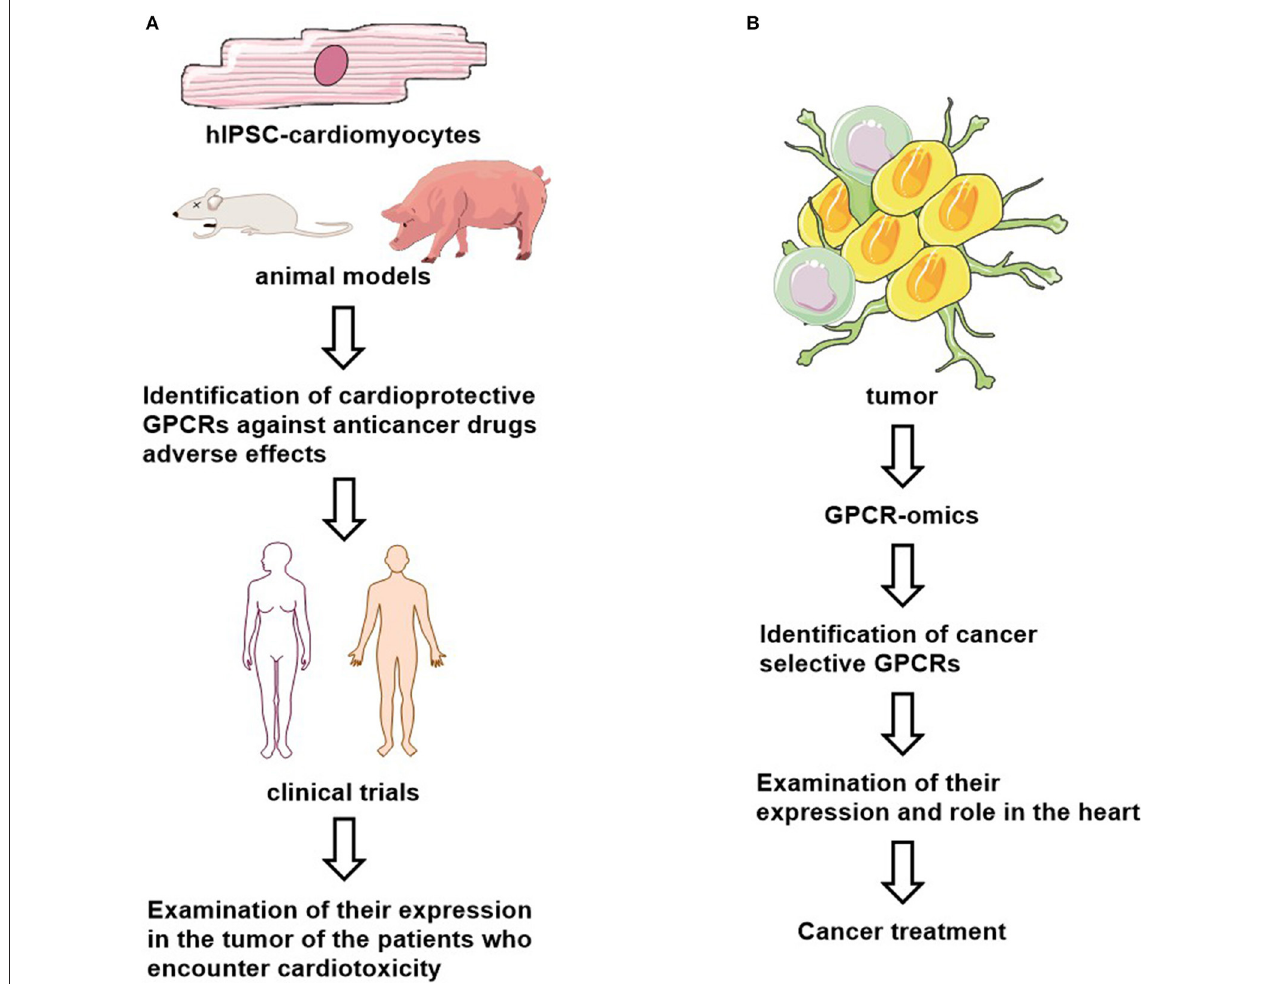
FIGURE 2 | Proposed cardioprotective (A) and anti-cancer (B) drug studies.